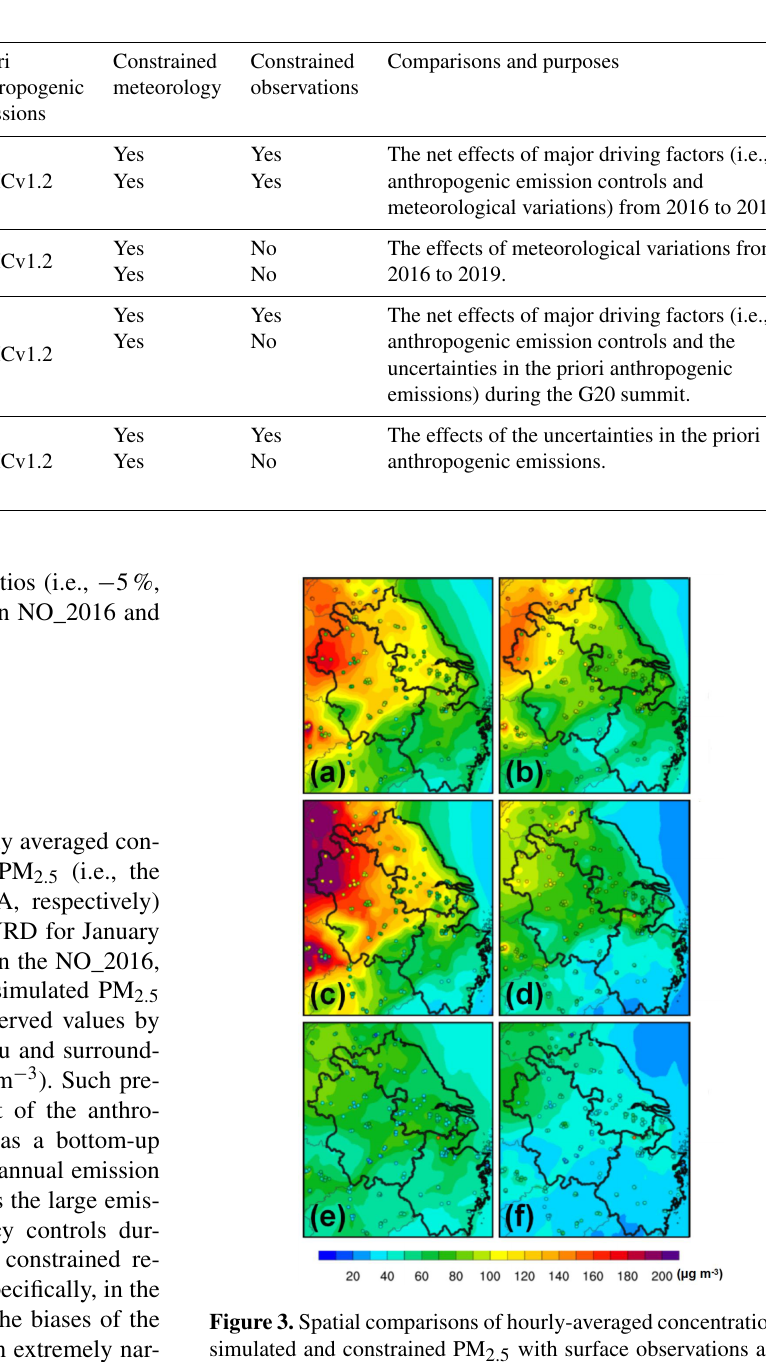
Table 1. The experiments to isolate the effects of anthropogenic emission controls due to the long-term and emergency emission control strategies.